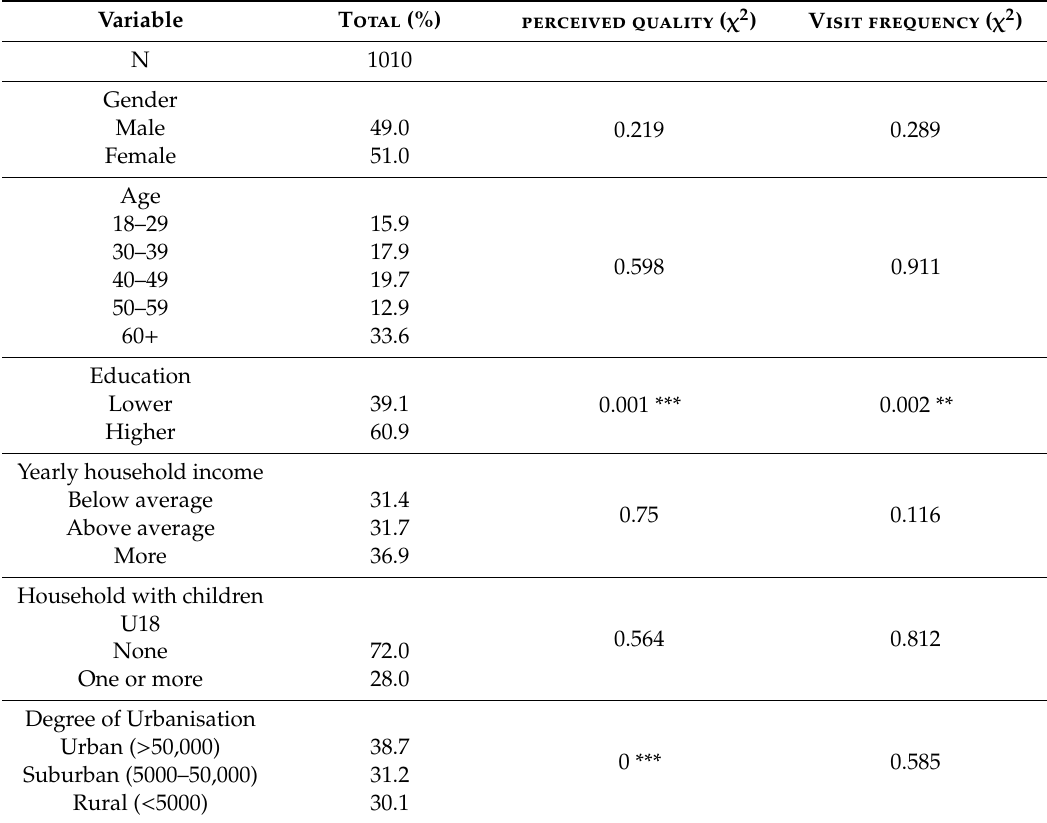
Table 2. Population characteristics and Pearson chi-square test ( χ 2 ) results for quality and visit frequency and predictor variables derived from a Norwegian study of 1010 adults (significance levels: 0 ‘***’, 0.001 ‘**’, 0.01